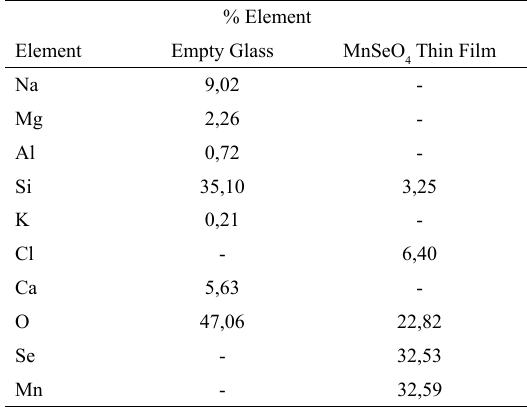
pH 10 compared to the other films, so the interaction of the light with the particles was higher in this regular